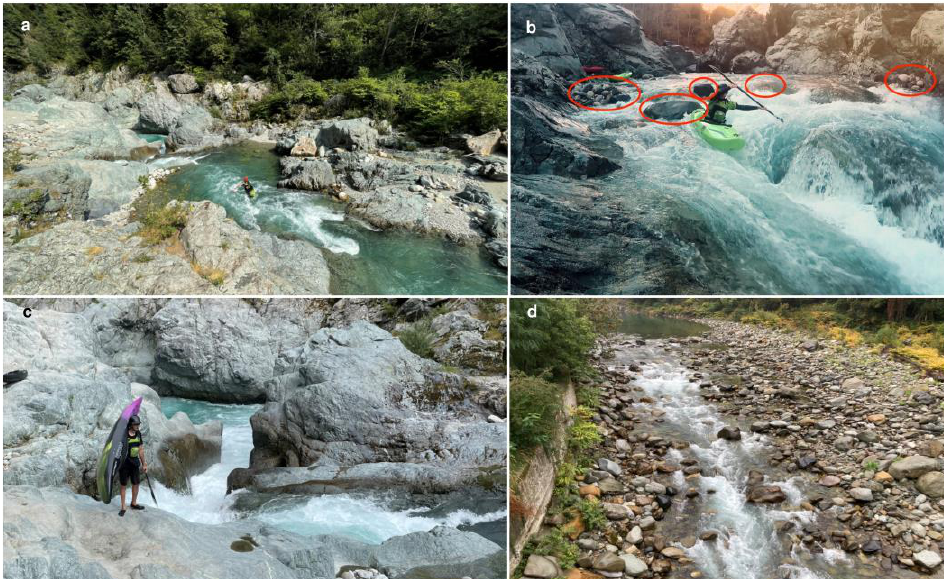
Figure 9. Examples of rapids of different WW degree along the investigated segments of Gole del Sesia (GS), Classico del Sesia (CS), and Canyoning Sorba (CNS). ( a ) GS-M-AM, rapid IV WW degree; ( b ) GS-M-AP, rapid Nicchia, IV WW degree; ( c ) GS-M-AN, step Impraticabile, not graded; ( d ) CS-M-AP, rapid Aperitivo, III WW degree. See location in Figure 8. Red ellipses in ( b ) indicate the mobile debris in the riverbed. For abbreviations, please see Section 3.1.